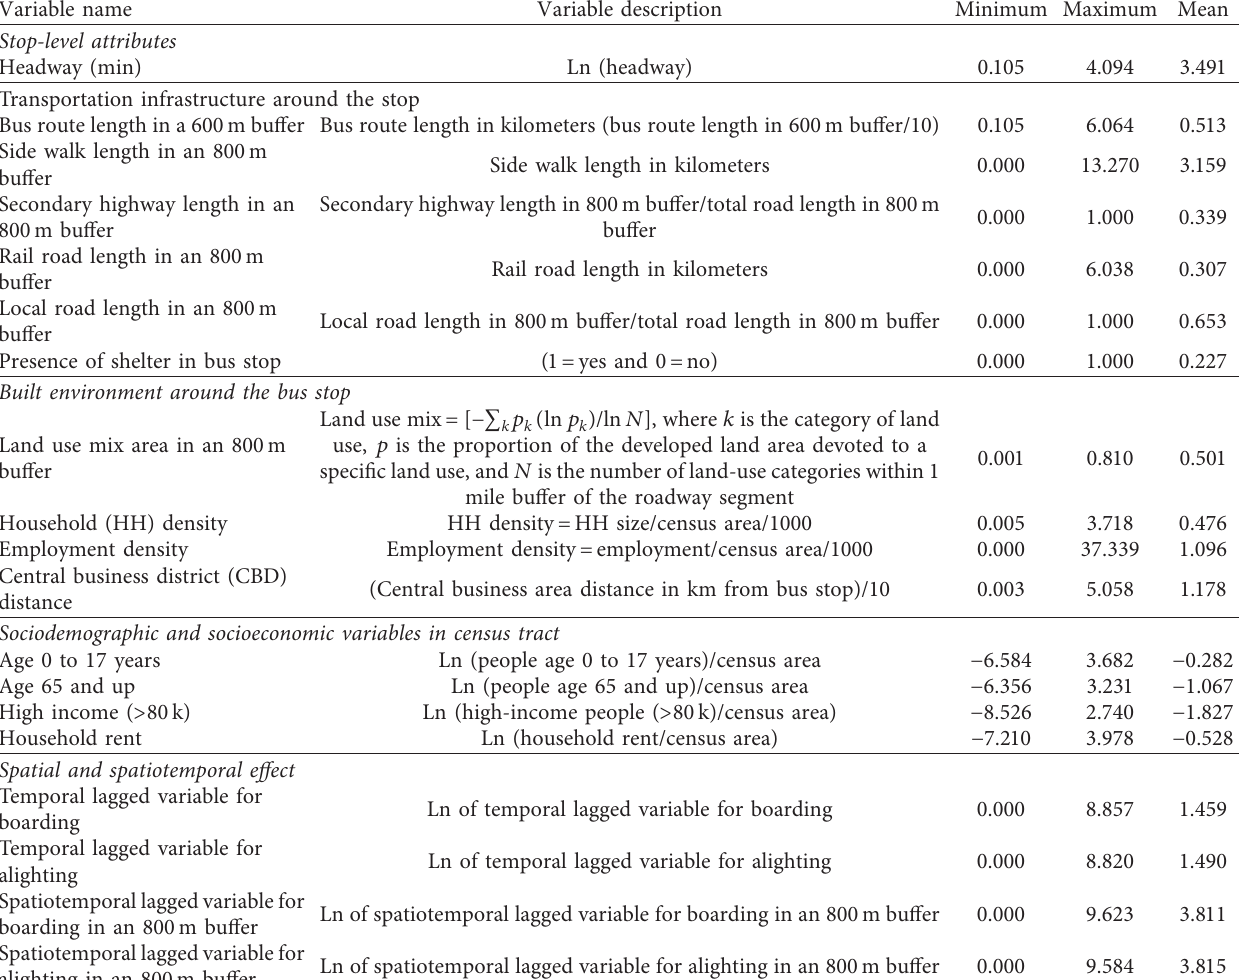
Table 2: Descriptive statistics of exogenous